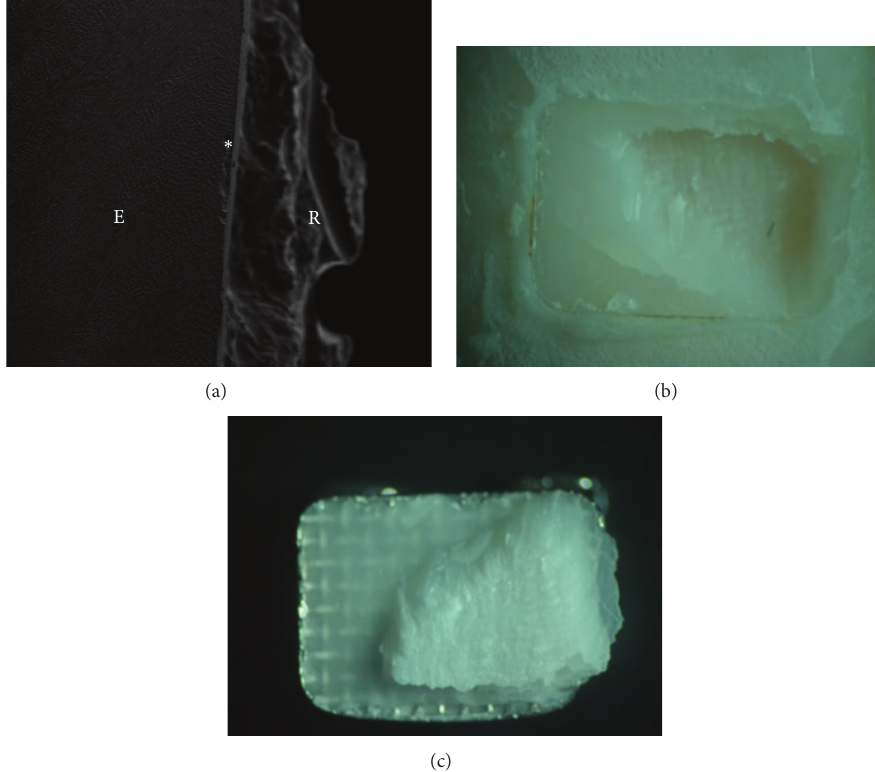
Figure 2: (a) Images of group QC. (a) Magnification of 500x showing injuries in the enamel with the bracket debonding. (b) Images in stereomicroscope of the tooth buccal and (c) bracket